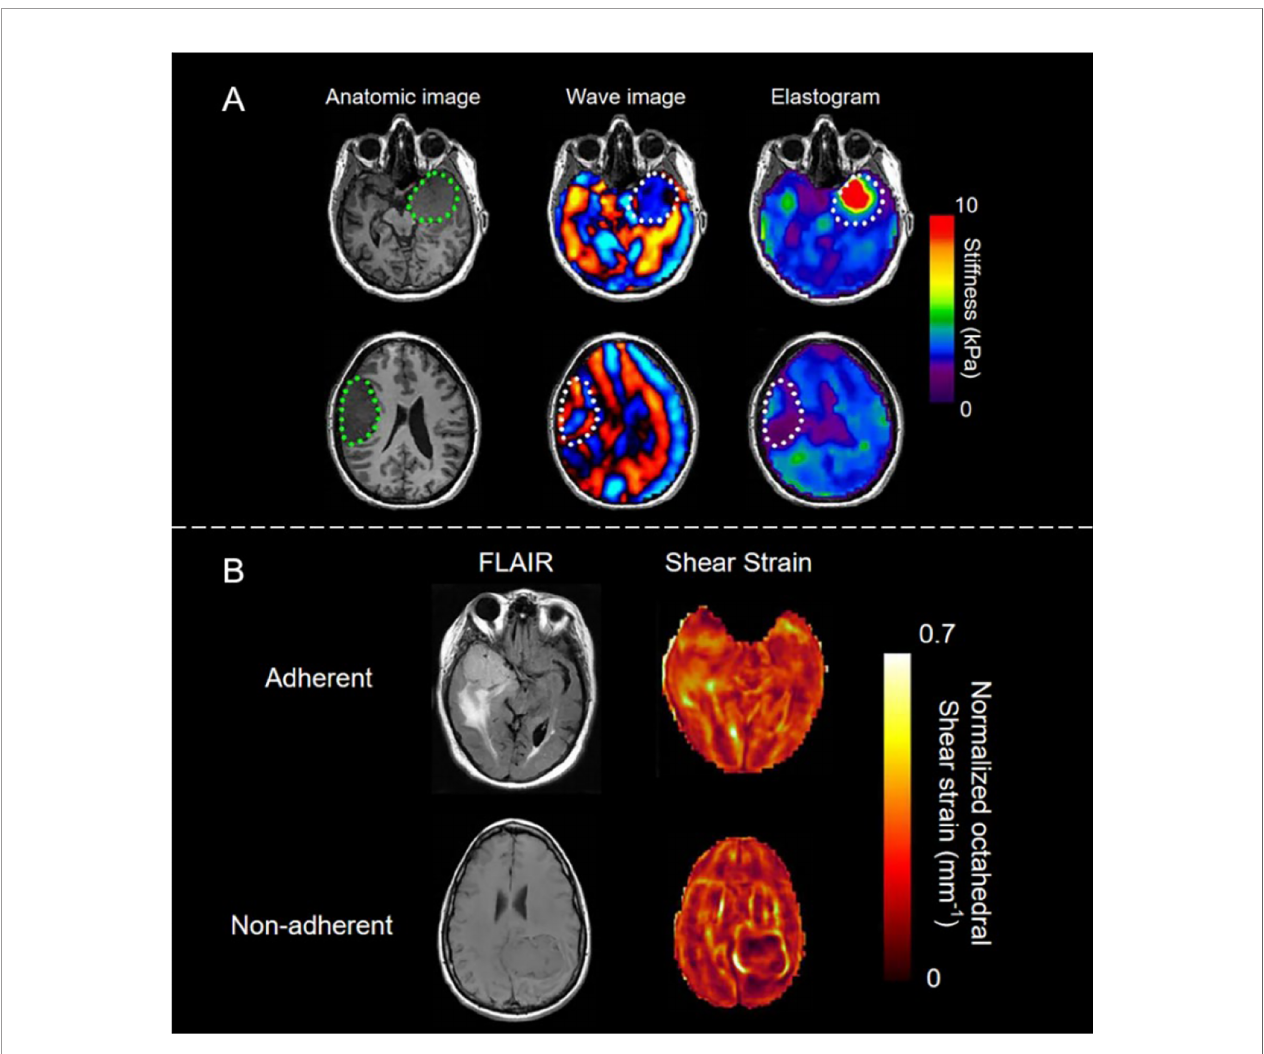
FIGURE 4 | (A) Brain imaging of stiff meningioma subjects (top row) and soft meningioma subjects (bottom row). The area encircled by the green dots represents the location of the tumor. Normal brain parenchyma, dural meningioma, and soft meningioma have different mechanical properties, indicating the great potential of MRE in brain imaging. Reproduced with permission from ref. (62), copyright 2013, American Association of Neurological Surgeons. (B) The image of a sliding interface in the case of adherent (top) and non-adherent (bottom) meningiomas. In non-adherent cases, the tumor was surrounded by bright rings. Left: T2-weighted fl uid-attenuated inversion recovery (FLAIR) images; Right: shear strain maps. Reproduced with permission from ref.